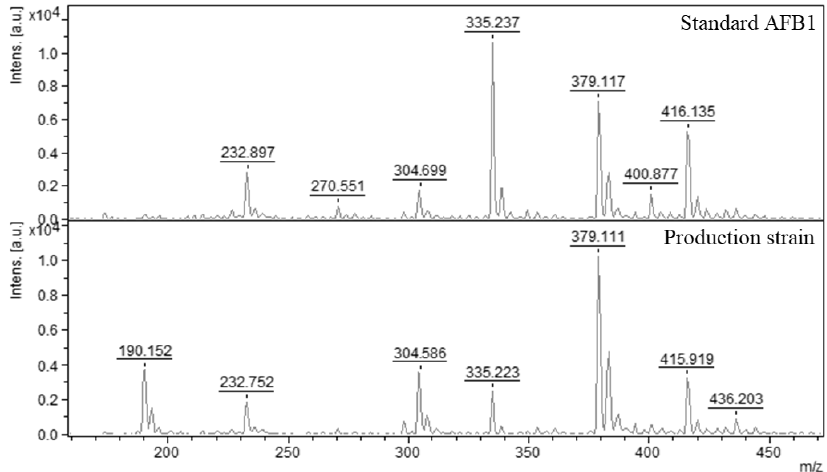
Figure 2. MALDI-TOF mass spectra of AFB 1 obtained by scraping from TLC plate. Standard AFB 1 (335.237 m/z) and producing strain of A. flavus (335.223 m/z).